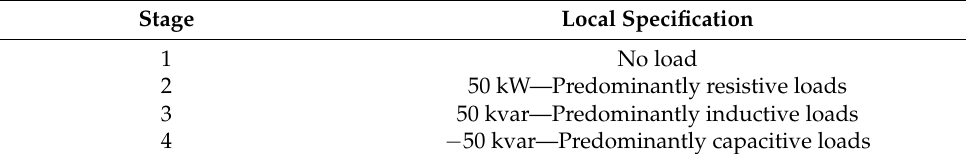
Table 2. System conditions during the tests.